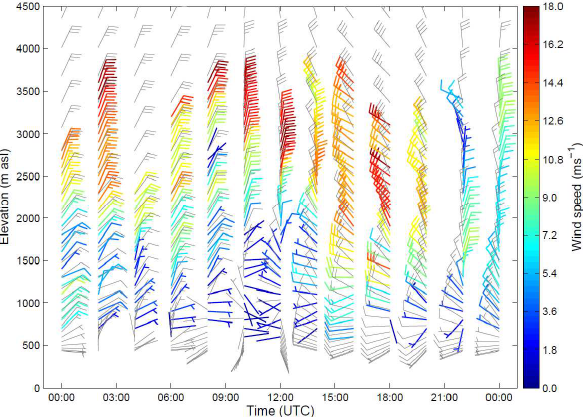
Fig. 8. The 16 October 2009 wind profile case study as measured (colour barbs) and modeled (grey barbs) in Grenchen in the centre of the CN MET domain. The altitude range is given for the high resolution wind profiler mode and the data display is given only every 2